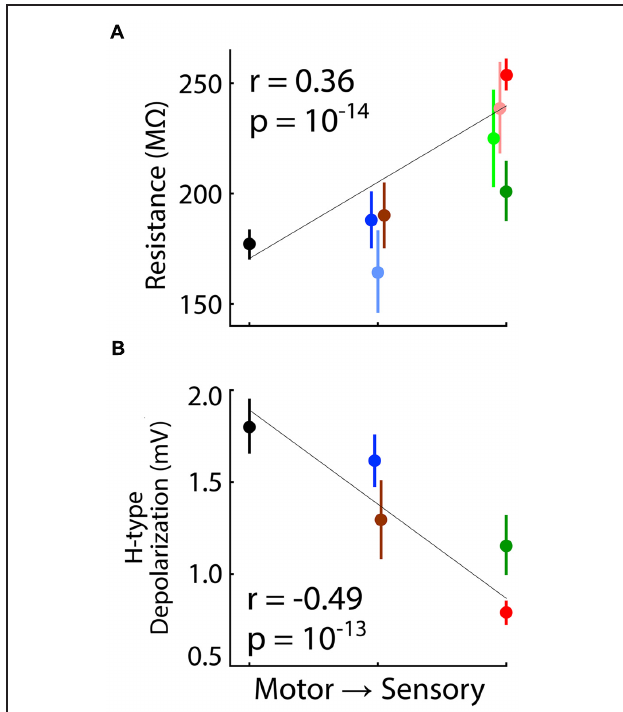
FIGURE 10 | Correlation of input resistance and H-type depolarization with distance from motor output. Format analogous to Figure 9 . (A) Input resistance and (B) H-type depolarization were correlated with distance from motor output as ranked according to scheme 1 ( Table 3 ). Values of ‘ r ’ and ‘ p ’ are shown for correlation across all individual neurons, but correlations were also significant across population